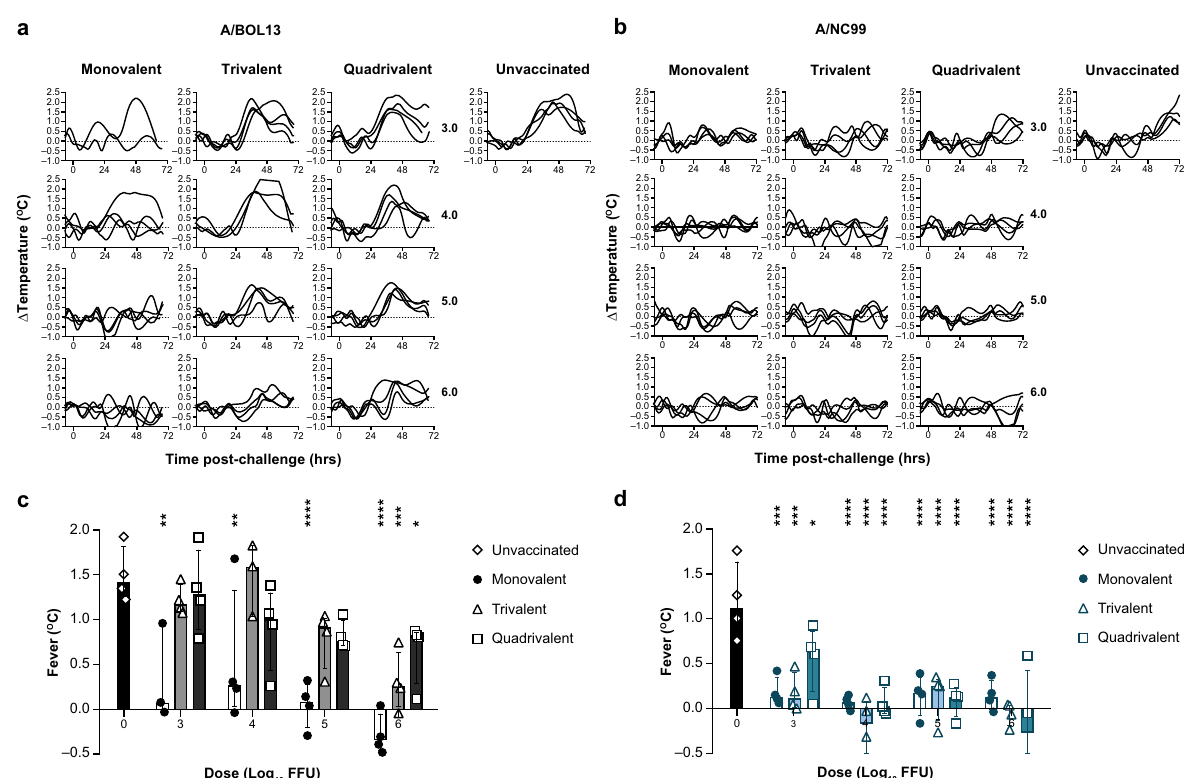
Fig. 4 A/BOL13 provides reduced protection against in fl uenza-like illness. Change in ferret core body temperature was measured hourly from pre-vaccination to study termination. Change in individual animal body temperature versus baseline ( Δ temp [°C]) following wild-type challenge for all animals is shown in a (A/BOL13) and b (A/NC99). Curves are spline fi ts to hourly data. Individual fever values are summarized in c (A/BOL13) and d (A/NC99). Temperature traces from two animals in the A/BOL13, 3.0 log 10 FFU, monovalent LAIV-dose group were corrupted and had to be excluded from this analysis. Bar graphs show fever values from individual animals (symbols), four animals per dose group. Fever temperatures shown are the average increase over baseline body temperature post-challenge, as described in “ Methods ” . Columns and error bars show group median and interquartile range. Statistical assessment of fever was conducted using two-way analysis of variance with Sidak ’ s post-test correcting for multiple comparisons. All vaccinated groups were compared with unvaccinated controls. * P < 0.05, ** P < 0.01, *** P < 0.001, **** P < 0.0001. LAIV live attenuated in fl uenza vaccine, A/BOL13 A/Bolivia/559/2013, A/NC99 A/New Caledonia/20/1999, FFU fl uorescent focus While fever and wt shedding endpoints were intended to A/BOL13 demonstrates reduced protection from wt virus shedding relative to A/NC99 simulate clinical VE study format, ferret respiratory tissues were also harvested for assessment of wt virus titer by TCID 50 at Day 3 To simulate patient sampling in test-negative VE studies, post- post-challenge. Challenge virus titers in nasal turbinate tissues challenge wt virus shedding was assessed by nasal swabs taken provided similar observations to wt virus shedding, with A/NC99 daily on Days 1 – 3 post-challenge, with virus titers measured by conferring reduction in virus titer at lower doses than A/BOL13 in TCID 50 and RT-qPCR. Figure 5 shows wt shedding kinetics and all formulations (Supplementary Fig. 6a and 6d). Due to insuf fi cient geometric mean Days 1 – 3 shedding for statistical assessment of volume for a subset of tissue samples, TCID 50 data could not be protection in vaccinated groups. generated for 4.0 log 10 FFU A/NC99 TLAIV and QLAIV. MLAIV A/BOL13 vaccination provided signi fi cant reduction in In lung tissue of A/BOL13-vaccinated animals, wt virus was median wt shedding relative to unvaccinated controls at all doses undetectable in MLAIV-vaccinated animals as well as the majority ( P < 0.0001 for all groups). However, again, individual animals in of 5.0 or 6.0 log 10 FFU TLAIV- and QLAIV-vaccinated ferrets each of the 4.0 and 3.0 log 10 FFU dose groups showed no (Supplementary Fig. 6c). However, wt virus titers in lung tissues response to vaccination, failing to reduce wt virus titer (Fig. 5a). were generally low by TCID 50 , including in unvaccinated controls. Similar to the results from assessment of fever, all A/BOL13 For greater sensitivity, lung titers were also assessed by RT-qPCR TLAIV- and QLAIV-vaccinated groups showed incomplete protec- (Supplementary Fig. 6b). By RT-qPCR, 5.0 and 6.0 log 10 FFU TLAIV tion from challenge virus replication. Only a 6.0 log 10 FFU TLAIV doses resulted in undetectable levels of wt vRNA in all animals, dose gave a signi fi cant reduction in wt virus shedding, relative to while two of four animals in both 4.0 and 6.0 log 10 FFU QLAIV unvaccinated controls ( P = 0.0015). Even in this case, median wt groups were similarly protected. shedding remained in excess of 3.0 log 10 TCID 50 /ml. By contrast, For A/NC99, by TCID 50 , wt virus was undetectable in lung tissues A/NC99 vaccination gave signi fi cant reductions in wt shedding in even in unvaccinated control animals (Supplementary Fig. 6f). all vaccine formulations at all doses, with the lone exception of the However, two control animals did give positive RT-qPCR readings 3.0 log 10 FFU QLAIV group. This indicated that, in line with the loss (Supplementary Fig. 6e). Together, these observations suggested of protection against fever already shown, A/BOL13 in TLAIV and that successful wt upper respiratory tract infection did not QLAIV provided reduced protection against wt virus replication, guarantee development of lower respiratory tract infection by relative to MLAIV, while A/NC99 was less affected. Day 3 post-challenge and that sterilizing protection of the lungs